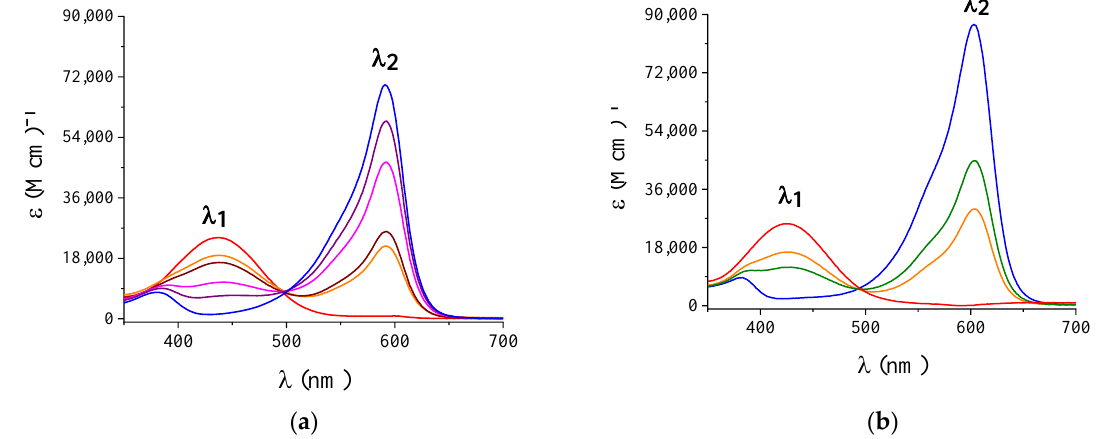
Figure 1. VIS spectra of BPB solutions at various pH values: ( a ) pH = 1.19 (red); 3.80 (orange); 3.99 (brown); 4.59 (magenta); 4.87 (violet); 6.59 (blue); ( b ) pH = 1.19 (red); 2.39 (orange); 2.60 (olive); and 4.47 (blue). The total concentration of the buffer solutions is constant and equal to ≈ 0.08 M. In ( b ) C T = 0.0123 M CTApTs.